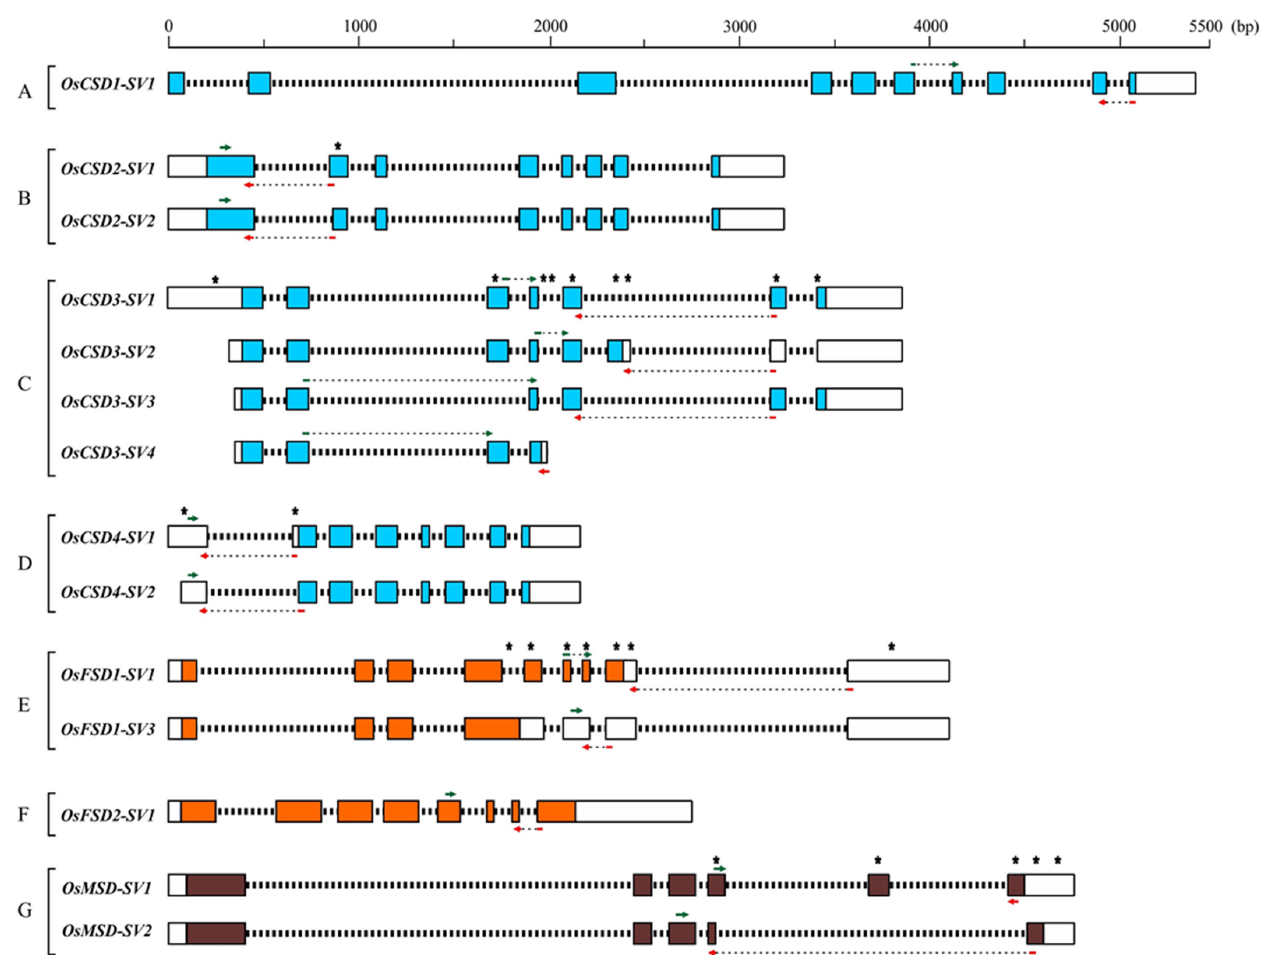
Figure 1. Schematic representation of splice variant transcripts of rice CuZn, Fe, and Mn-SODs as available at the Rice Genome Annotation Project (RGAP) website (http://rice.plantbiology.msu.edu/). (A) LOC_Os03g22810 ( CSD1 ), (B) LOC_Os08g44770 ( CSD2 ), (C) LOC_Os03g11960 ( CSD3 ), (D) LOC_Os07g46990 ( CSD4 ), (E) LOC_Os06g05110 ( FSD1 ), (F) LOC_Os06g02500 ( FSD2 ) and (G) LOC_Os05g25850 ( MSD ). The three types of SODs are represented by different colors, blue (CuZn-SODs), orange (Fe-SODs), and brown (Mn-SOD). Scale on the top indicates the relative sizes of the genes and positions of exons and introns. Colored boxes represent exons, white boxes represent untranslated regions (UTRs), and thick black dashed lines represent intronic regions. Forward and reverse primer binding regions are indicated by green and red arrows (the thin dashed line connecting the arrowhead and tail indicates the continuity of the primers designed at the exon-exon/UTR junction). Asterisk (*) indicates the exon/UTR regions that show heterogeneity between the splice variants of a gene.